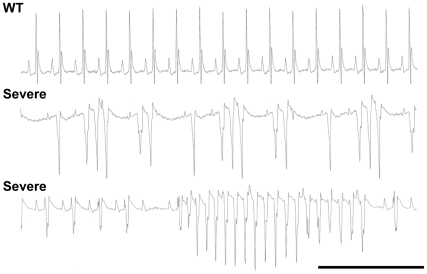
Cardiac arrhythmias in Scn5a
+/− mice with severe phenotype.Representative episodes of spontaneous ventricular arrhythmias recorded in two different Scn5a
+/− mice with a severe phenotype under anesthesia. An ECG recorded in an age-matched WT mouse is given for comparison. Scale bar, 500 ms.